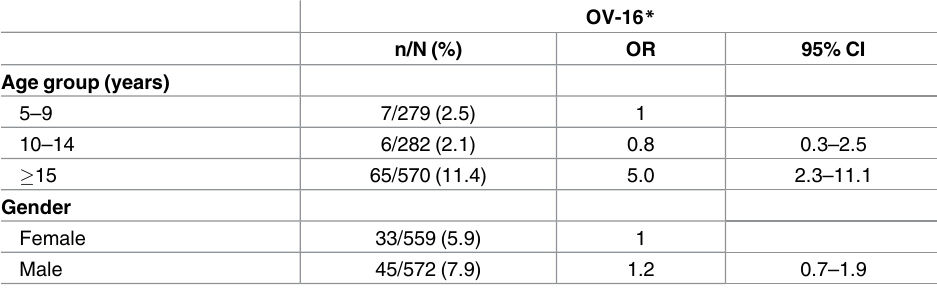
Table 5. Prevalence of onchocerciasis antibody positive results by age and gender, Ke´dougou